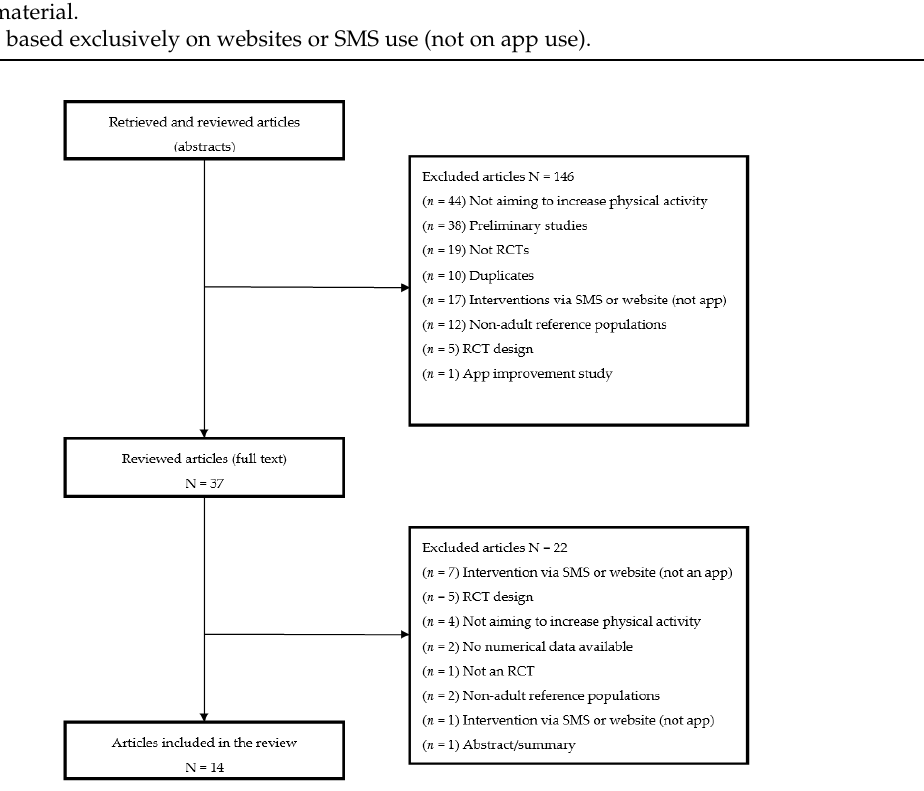
Figure 1. Search results and selection process.